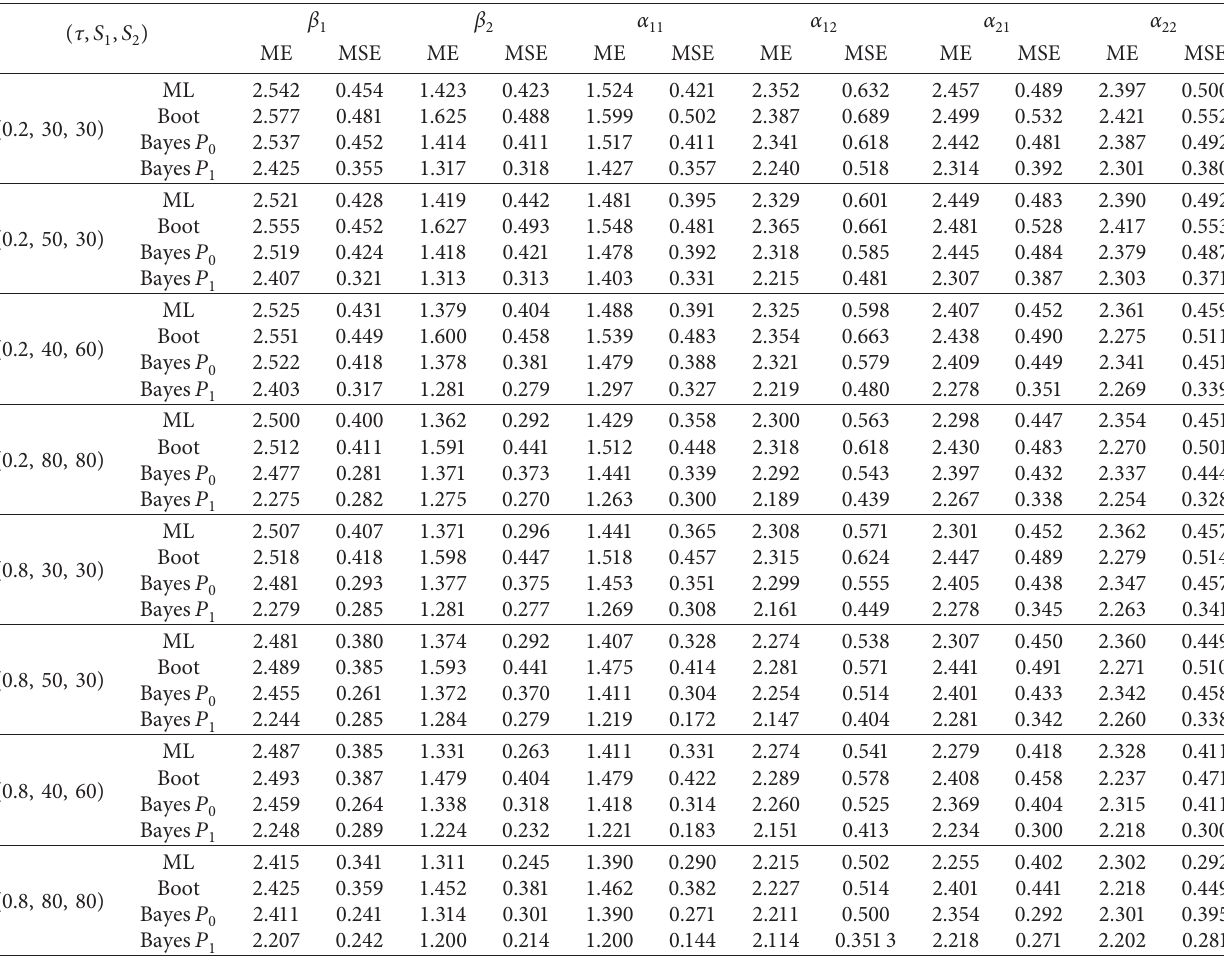
Table 5: The ME and MSEs of ML, boot, and Bayes methods under ω � 2 . 0 , 1 . 2 , 1 . 3 , 1 . 8 , 2 . 0 , 2 . 0 { } . ,S ) ( τ , S 1 2